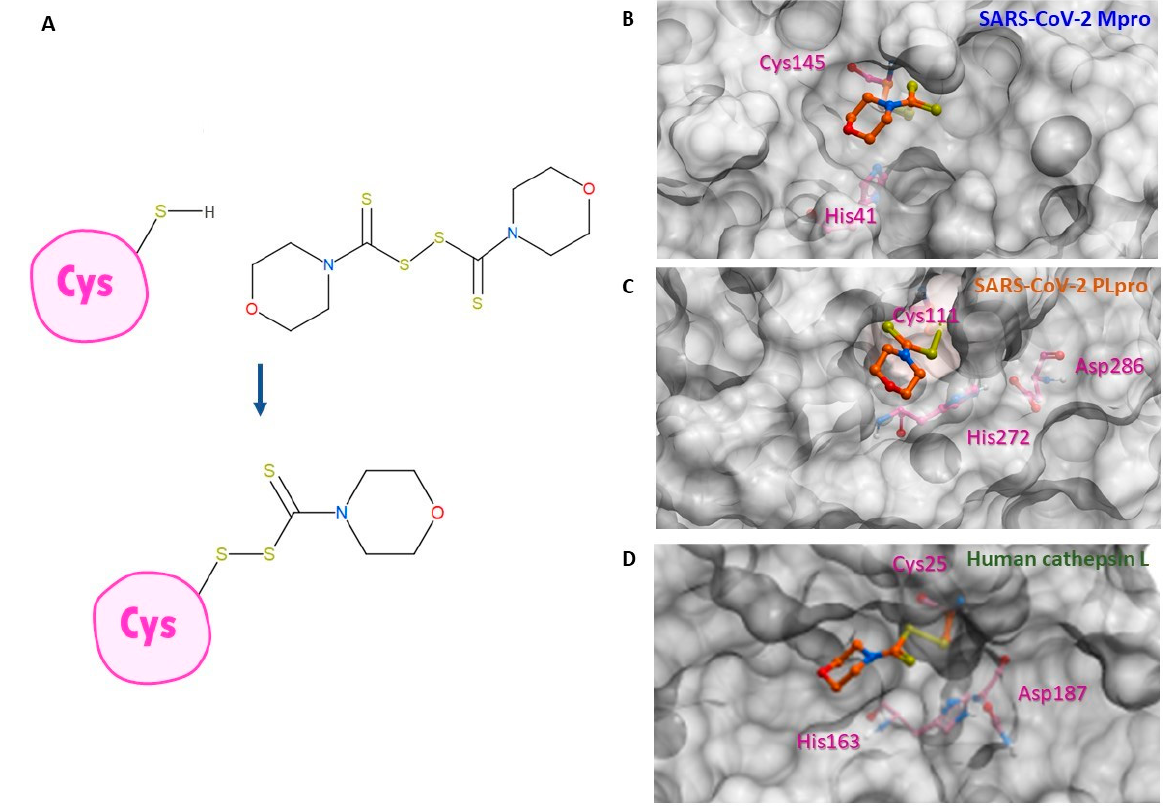
Figure 3. Binding conformation of thiuram disulfide or dithiobis-(thioformate). ( A ) The mechanism of RI173 when it covalently reacts to the active cysteine residue of SARS-CoV-2 Mpro and PLpro. ( B ) Predicted 3D conformation of RI173 shown as the orange stick in SARS-CoV-2 Mpro surrounded by catalytic dyads active residues Cys145 and His41. ( C ) Predicted 3D conformation of RI173 shown as the orange stick in SARS-CoV-2 PLpro surrounded by the catalytic triads active residues Cys111, His272, and Asp286. ( D ) Predicted 3D conformation of RI173 shown as the orange stick in human cathepsin L surrounded by catalytic triads active residues Cys25, His163, and Asp187.